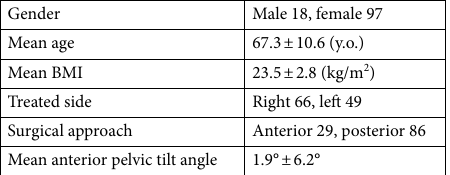
Table 1. Patients